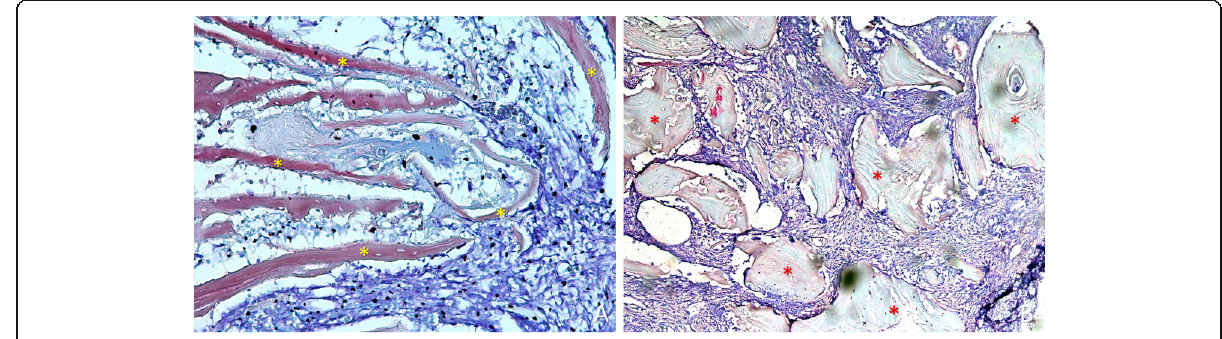
Fig. 4 Photomicrographs of ground sections. a ) Treated site. Bone residues (examples in yellow asterisks) included in soft tissue containing fibroblast-like cells and inflammatory cells. b ) Untreated site. Xenograft residues (examples in red asterisks) surrounded by soft tissue rich in fibroblast-like cells. Scarlet-acid fuchsine and toluidine blue stain. a ) 200 x magnification.; b ) 100 x